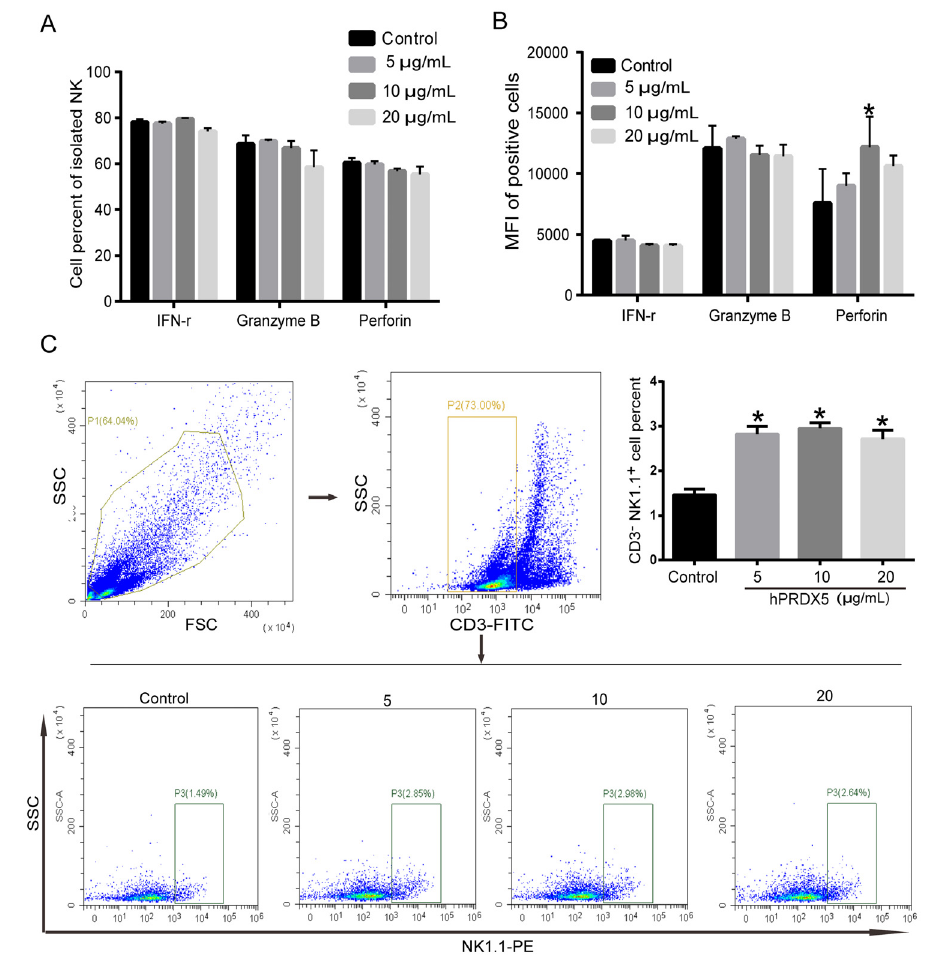
Figure 6. Effect of human peroxiredoxin-5 (hPRDX5) on the expression of function proteins of natural killer (NK) cells in vitro . A , The levels of IFN- g , granzyme B, and perforin in NK cells were assessed using fl ow cytometry. B , The mean fl uorescent intensity (MFI) of IFN- g , granzyme B, and perforin in NK cells was measured by fl ow cytometry. C , Proportion of NK cells in bone marrow mononuclear cells stimulated by hPRDX5 for 24 h in vitro . Data are reported as means ± SD. *P o 0.05, compared with the control